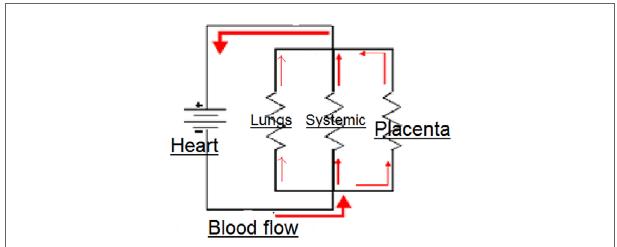
FIGUre 1 | Electrical circuit equivalent of fetal